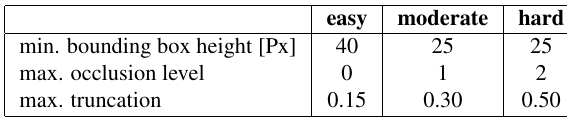
Table 1. Levels of difficulties as evaluation